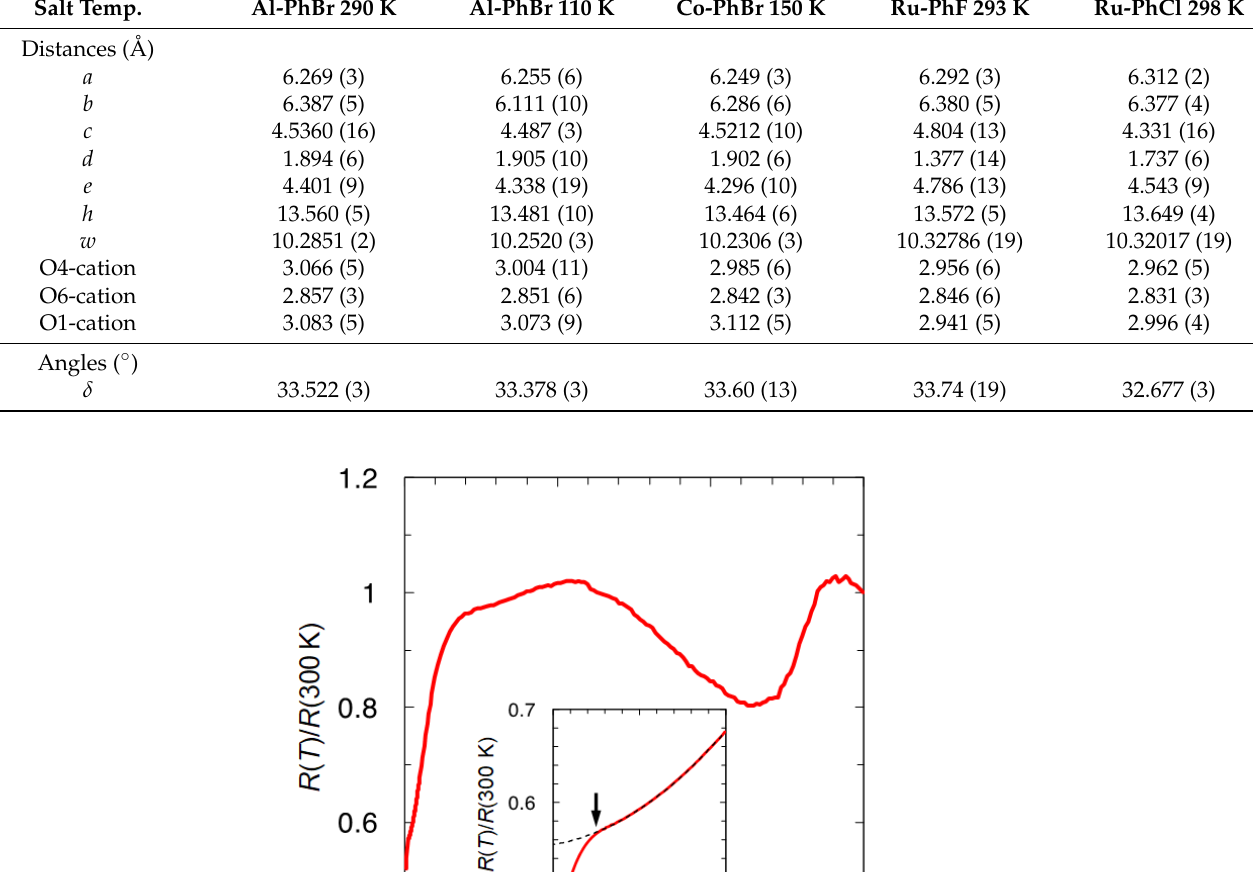
Table 4. Honeycomb cavity measurements in the anion layer (see Figure 3) of β″-(BEDT-TTF) 4 (H 3 O) M (C 2 O 4 ) 3 · G salts. Salt Temp.